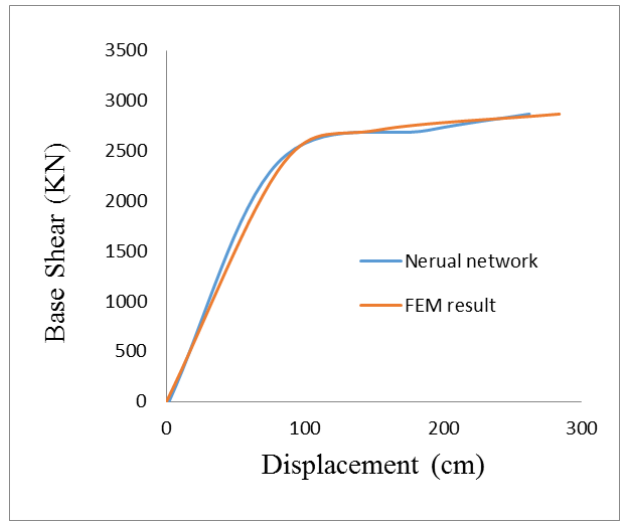
Figure 35. Neural network result for displacement.